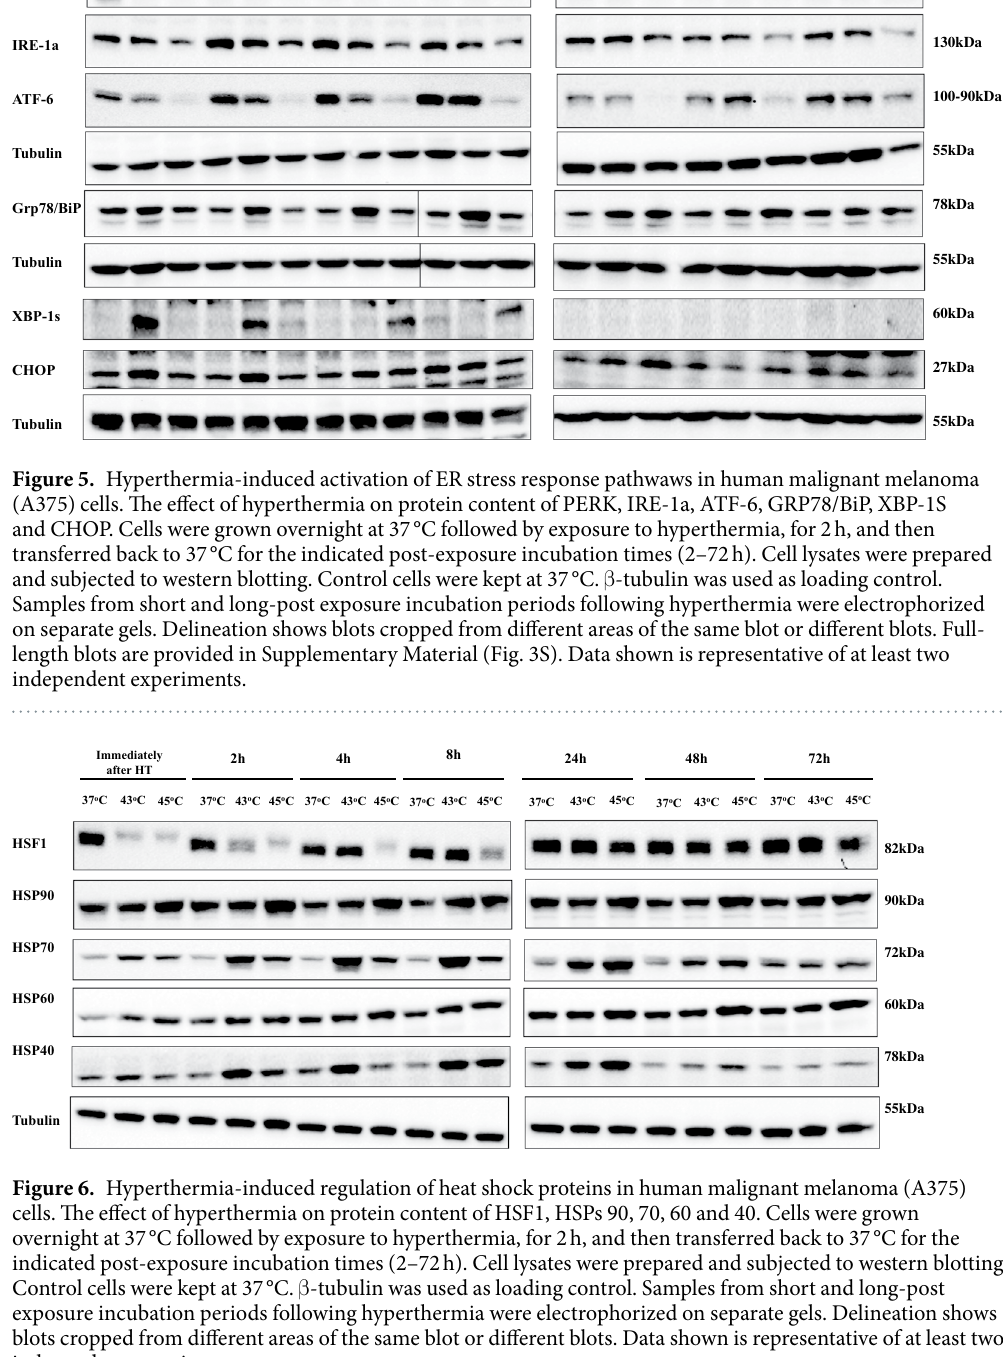
cell viability was potentiated in the presence of hyperthermia at 48–72 h post-exposure (Fig. 7A–C). In addition, Temozolomide (either alone or in combination with hyperthermia) also significantly reduced cell viability at 48–72 h post-exposure in a manner similar to Dacarbazine. However, the observed hyperthermia-induced poten- tiation was more apparent than in the case of Dacarbazine (Fig. 7D–F). On the other hand, similar observations were made in the case of targeted B-Raf V600E inhibitors namely Dabrafenib and Vemurafenib. In particular, the efficacy of Dabrafenib was remarkably enhanced when admin- istered in combination with hyperthermia at 24–48 h post-exposure (Fig. 7G–I) although the utilization of each